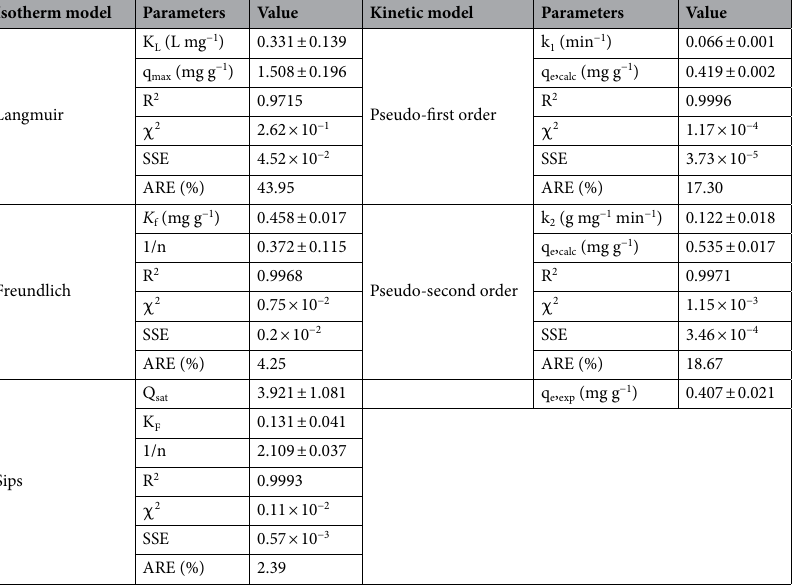
Table 3. Adsorption isotherms and kinetic models constants and the corresponding error